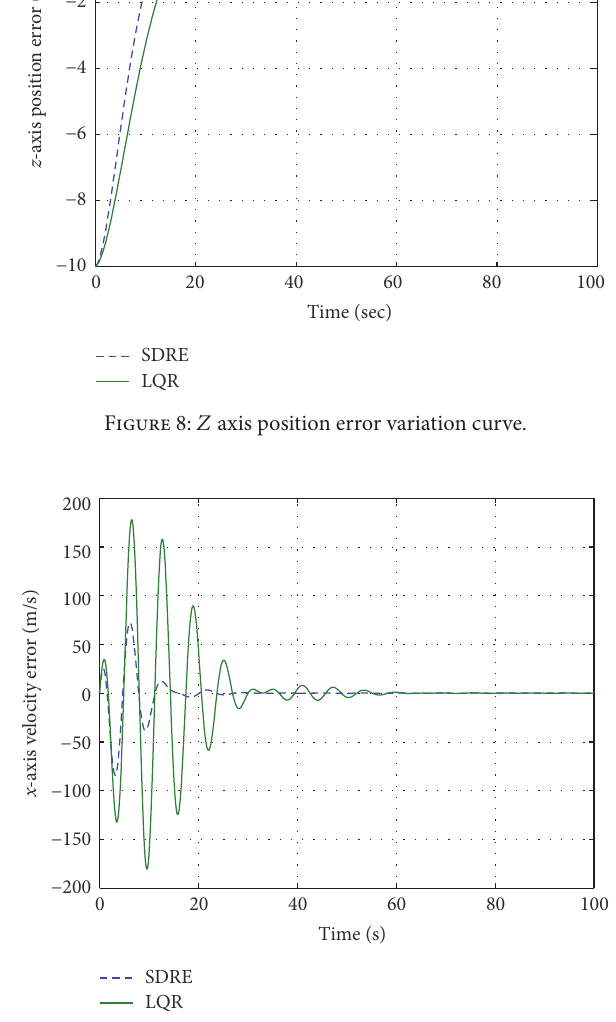
Figure 7: 𝑌 axis position error variation curve.